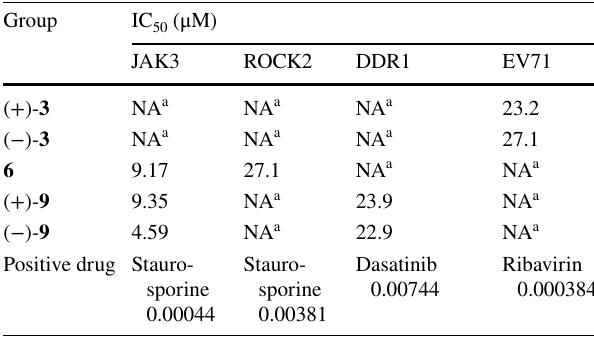
Table 5 Inhibitory effects of the isolates toward JAK3, ROCK2, DDR1, and